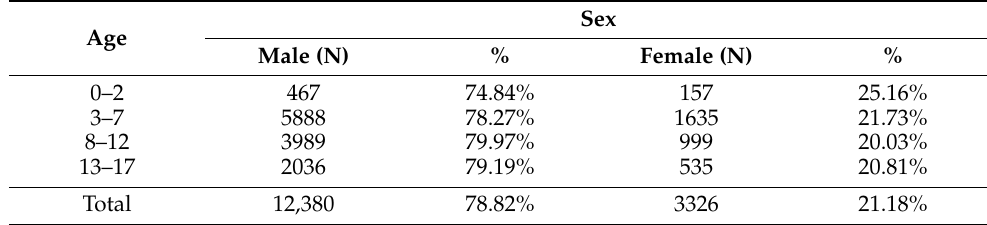
Table 5. Proportion of diagnoses of ASD per age and